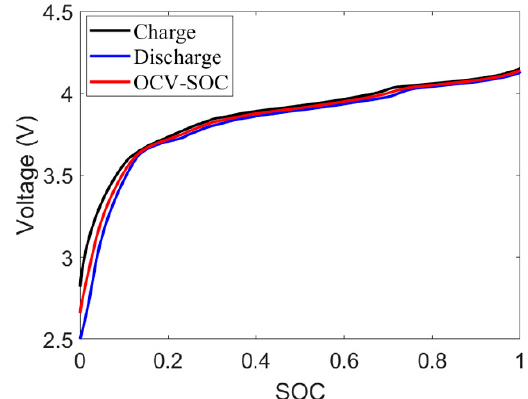
Figure 1. The Thevenin model for a lithium-ion cell. Here, OCV represents the open-circuit voltage U ocv ; R 0 represents the ohmic resistance; R 1 and C 1 in parallel represent the electrochemical reaction; I(t) is the current; U t is the terminal voltage. The current-voltage behavior is then described as: =